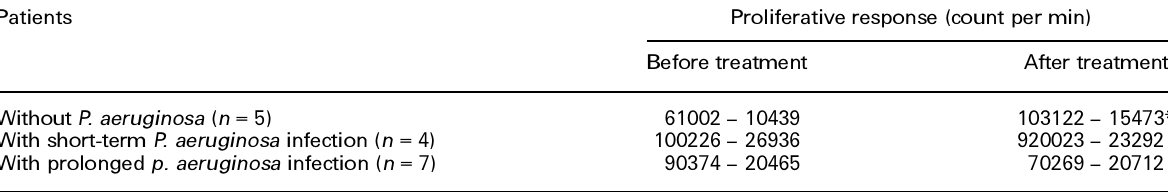
Table 1. Effect of antibiotic treatment on PHA-induced peripheral blood lymphocyte proliferation. Data are presented as mean ± SEM Patients